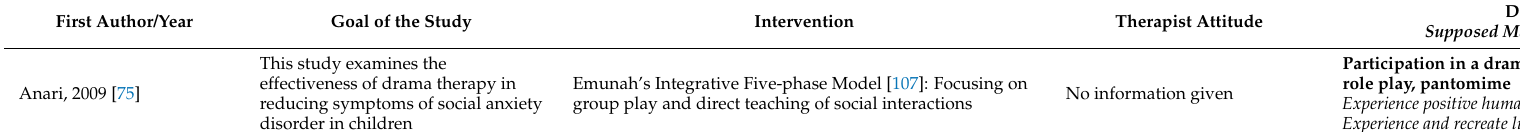
Table 3. Characteristics of drama therapy